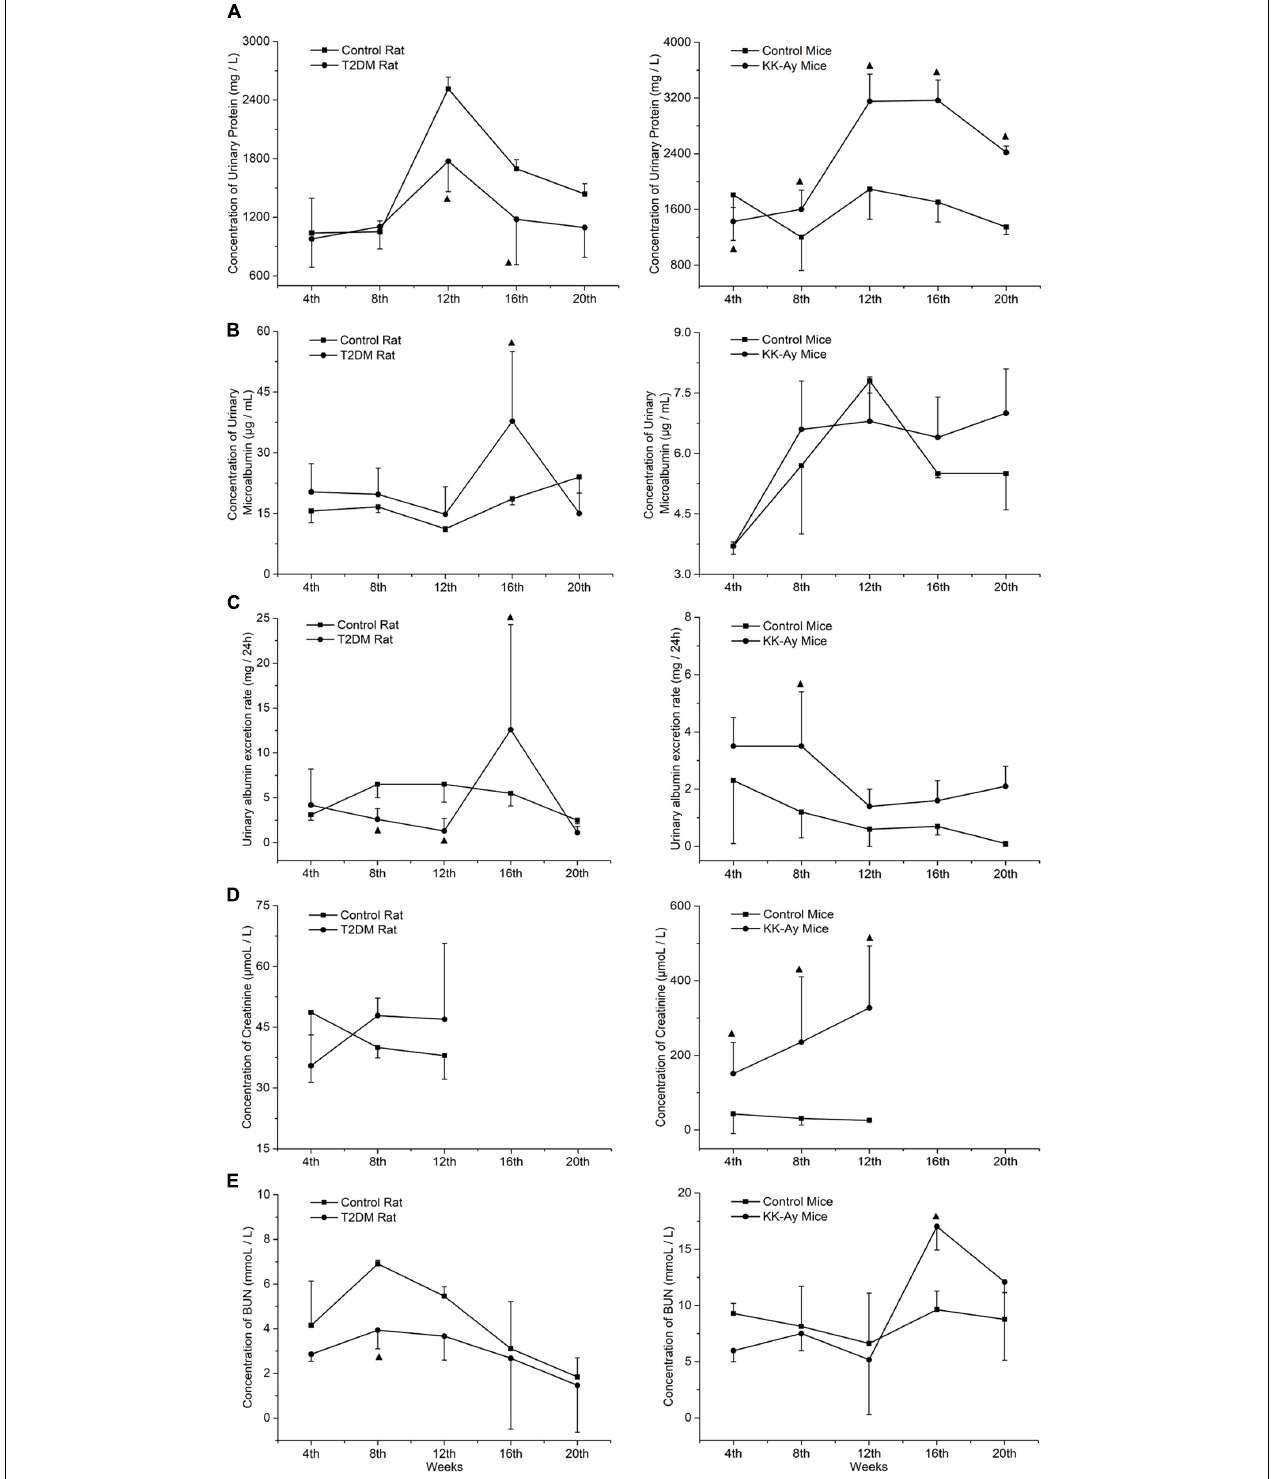
FIGURE 4 | Comparisons on the dynamic changes of renal function-associated parameters in T2DM rats and KK-Ay mice. (A–E) The dynamic changes in concentrations of urinary protein (A) , concentrations of urine microalbumin (B) , urinary albumin exclusion rate (UAE) (C) , concentrations of serum creatinine (D) , and concentrations of urea nitrogen (E) in T2DM rats (left) and KK-Ay mice (right) along with the indicated time points after the initial of modeling are shown (cid:78) P < 0.05, compared with the corresponding control group at the same time point.